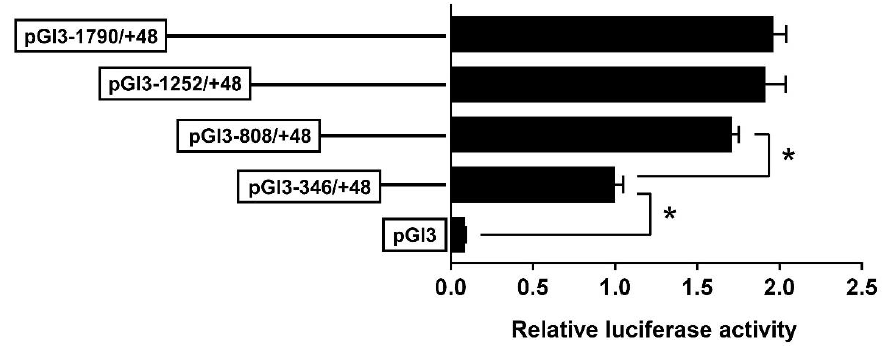
Figure 2. The 5 (cid:48) unidirectional deletion assays of the SHP promoter region of yellow catfish. Values mean the ratio of activities of firefly to Renilla luciferase normalized to the control plasmid. Results are shown as mean ± SEM ( n = 3). Asterisk (*) means significant differences between the two groups ( p < 0.05).